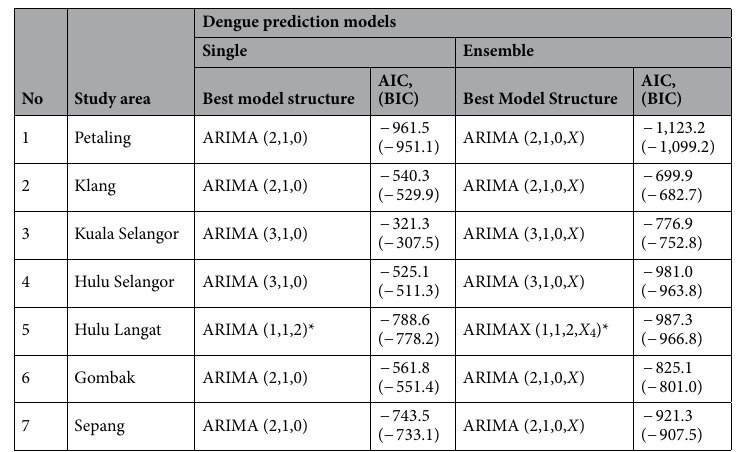
Table 3. A Comparison between single and ensemble dengue climate prediction